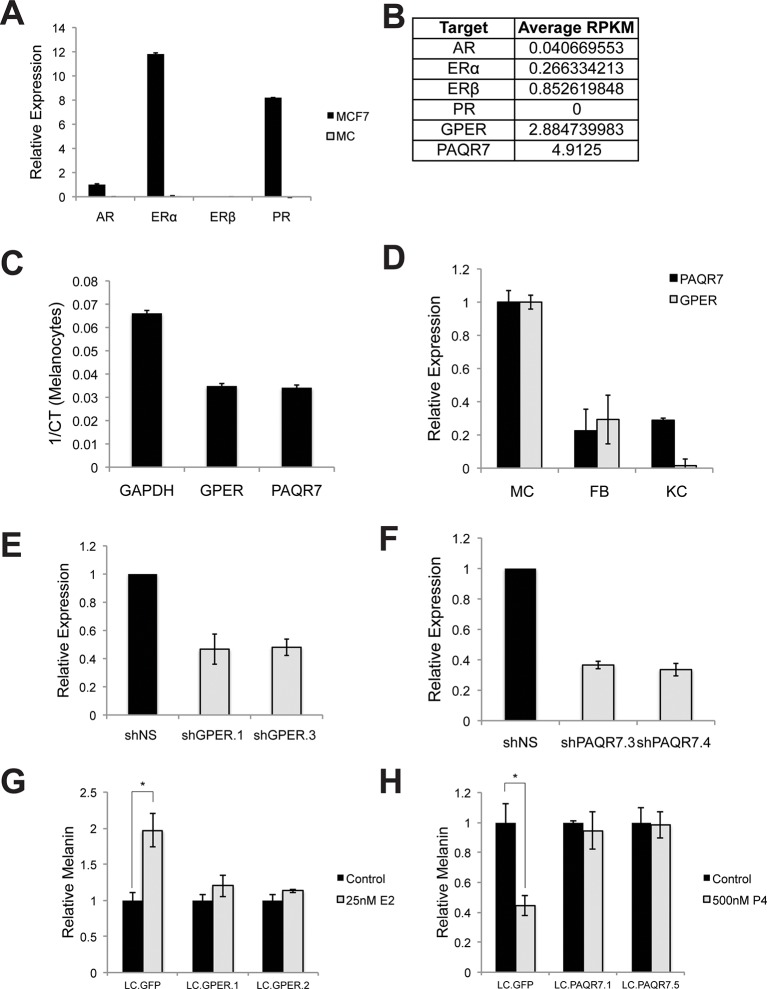
Hormone receptors in melanocytes.(A) Relative gene expression of classical hormone receptors in MCF7 cells and melanocytes, as determined by qRT-PCR. Ct values were normalized to actin, and set relative to the expression of androgen receptor (AR) in MCF7 cells. (B) Average RPKM values for classical and nonclassical estrogen and progesterone receptor transcripts in human melanocytes, by convention, RPKM values >1 indicate the gene is expressed. (C) Expression of GPER and PAQR7 displayed as 1/Ct value. (D) Relative expression of GPER and PAQR7 transcripts in melanocytes, fibroblasts, and keratinocytes, as determined by qRT-PCR, displayed relative to the expression level in melanocytes. (E) qRT-PCR showing mRNA knockdown efficiency of the two hairpins targeting GPER. (F) qRT-PCR showing mRNA knockdown efficiency of the two hairpins targeting PAQR7. (G) Melanin content of melanocytes transduced with LentiCRISPRV2 with guide RNA targeting GFP or GPER. Cells were treated with either vehicle or estrogen. (H) Melanin content of melanocytes transduced with LentiCRISPRV2 with guide RNA targeting GFP or PAQR7. Cells were treated with either vehicle or progesterone. Error bars denote +/- s.d., *p<0.05.